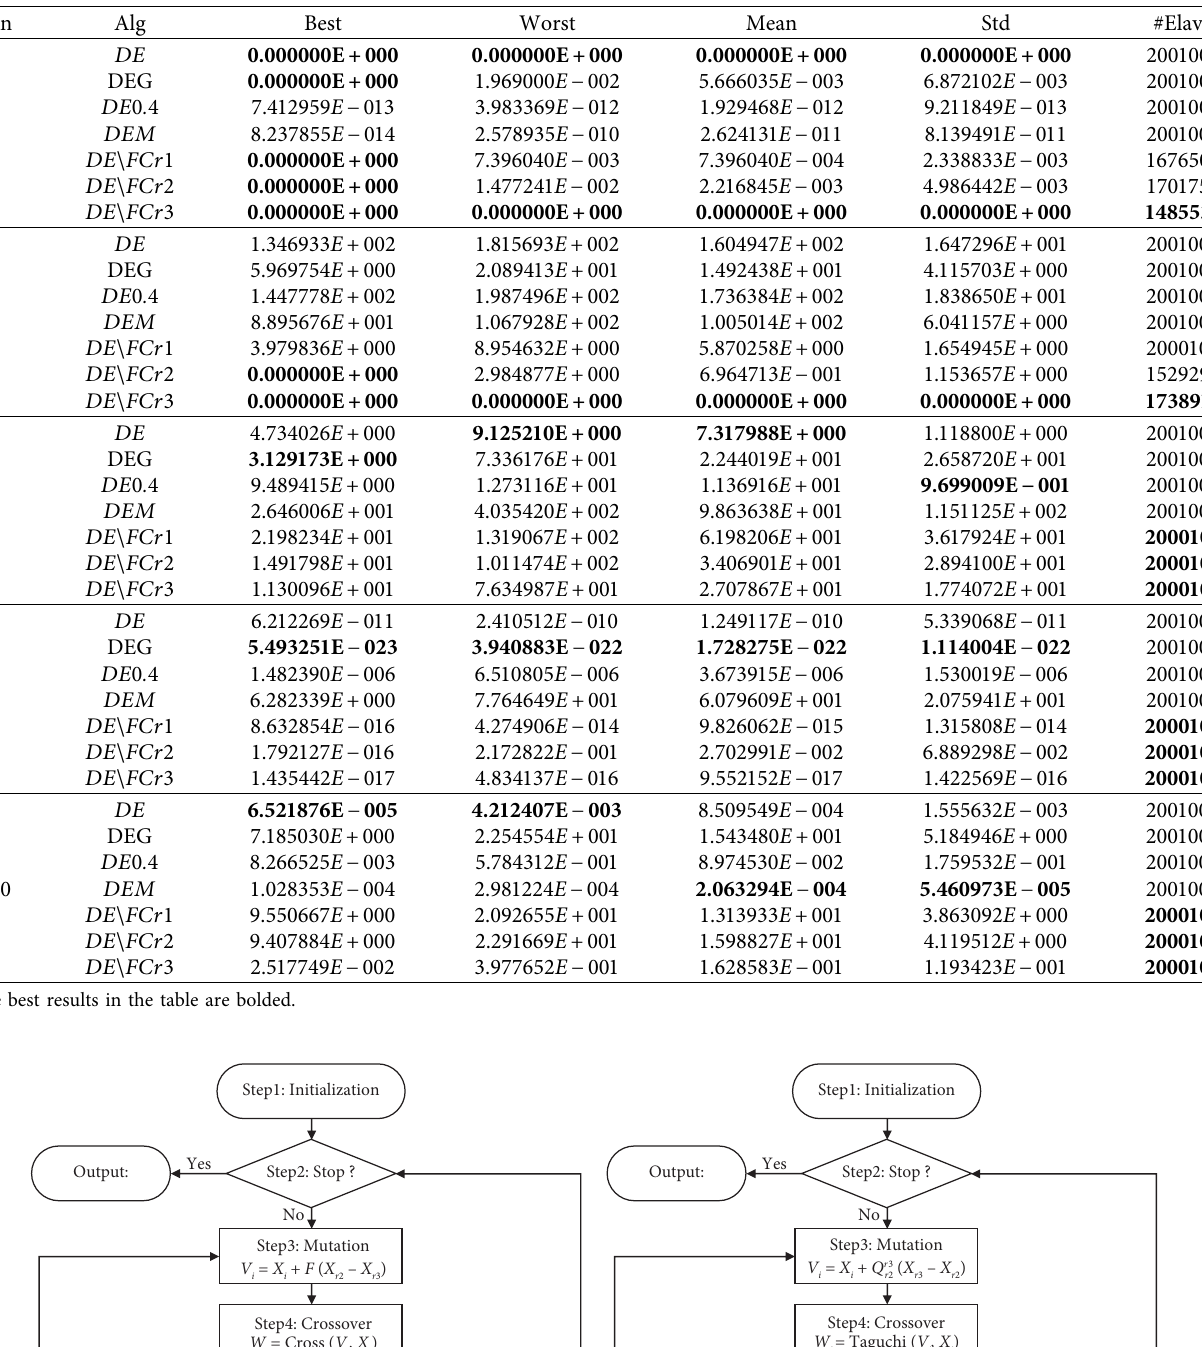
Table 4: Result comparisons among 7 algorithms for F 6– F